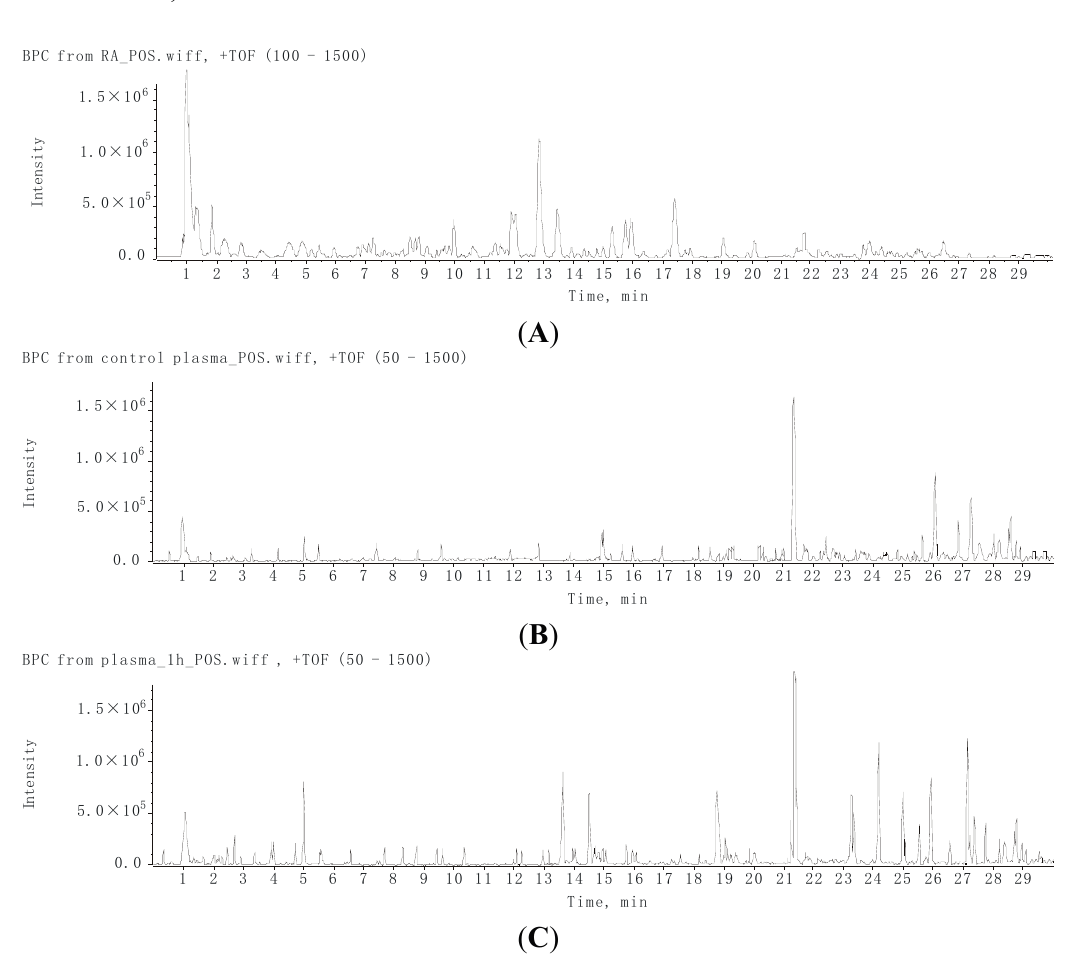
Figure 1. The positive ion chromatograms of RA extract ( A ); control plasma ( B ) and dosed plasma at 1 h ( C ).